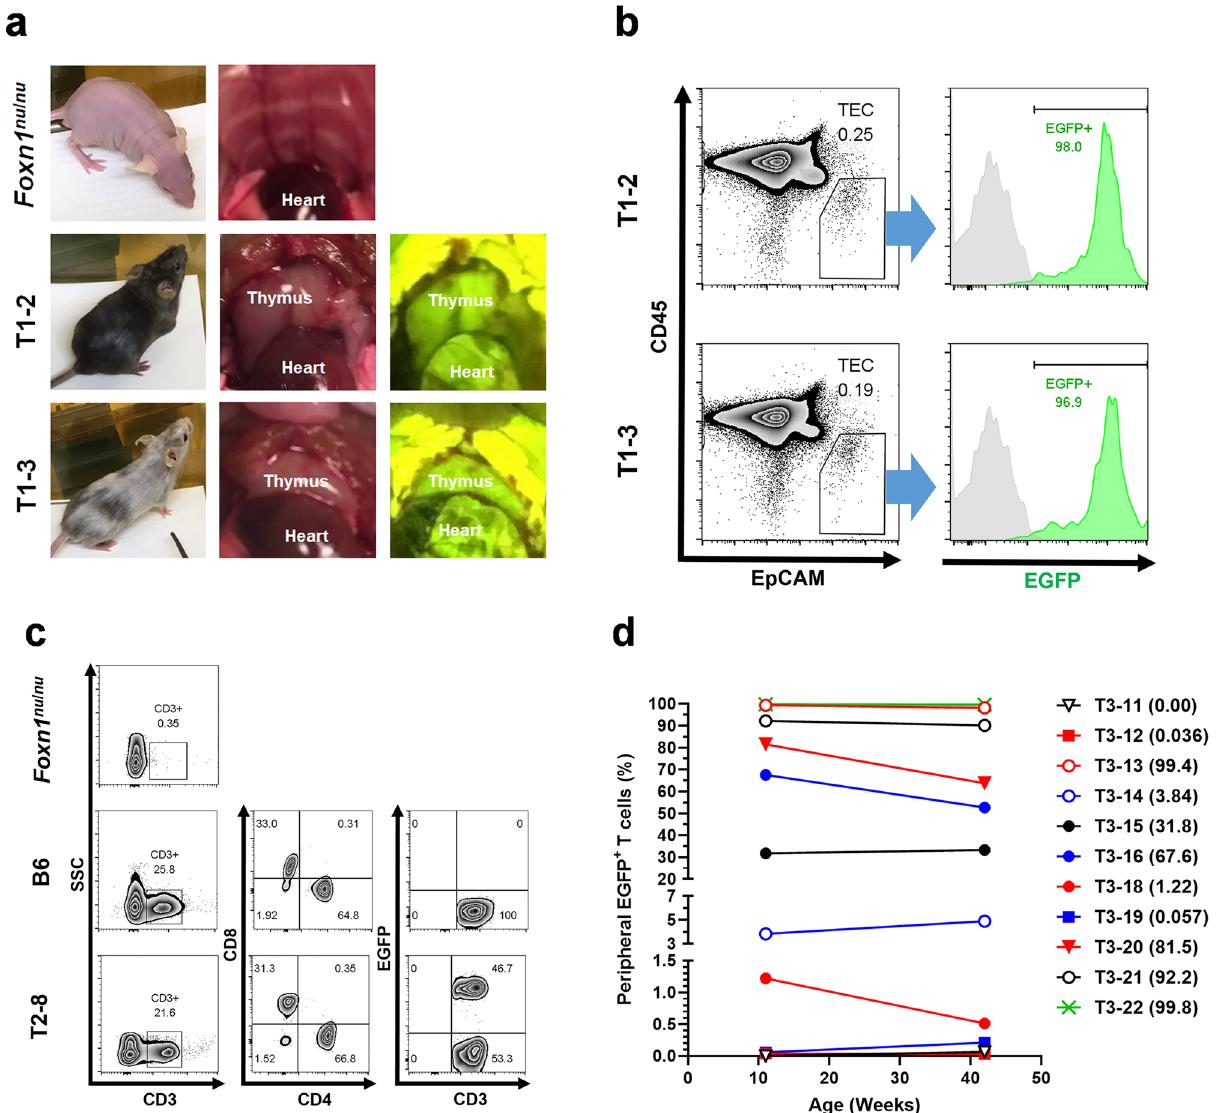
Figure 1. General characterization of thymus-complemented chimeric mice that were generated by blastocyst complementation—that is, injection of C57BL/6 (B6) embryonic stem cells expressing CAG-EGFP (ES CAG-EGFP ) into nude KSN/Slc ( Foxn1 nu / nu ) blastocysts. ( a ) Appearances and thymi of a nude ( Foxn1 nu / nu ) mouse and two B6 ESC CAG-EGFP → Foxn1 nu / nu chimeric mice (mice nos. T1-2 and T1-3). The nude mouse was athymic and both chimeras had EGFP-positive thymi. ( b ) Flow cytometry analysis of thymic cells derived from the two chimeric mice. Thymic cells were sorted against CD45 and EpCAM intensity, and the fractions of thymic epithelial cells (TECs; CD45 − EpCAM + ) were extracted (percentages of TECs were 0.25% and 0.19%, respectively), and then sorted against EGFP fluorescence. Almost all TECs of the chimeras were EGFP positive (98.0% and 96.9% in nos. T1-2 and T1-3, respectively). B6 control, gray; chimeras, green. ( c ) Generation of peripheral T cells in B6 ESC CAG-EGFP → Foxn1 nu / nu chimeras. Representative flow cytometry analysis of peripheral T cells of Foxn1 nu / nu , B6, and chimeric (mouse no. T2-8) mice, demonstrated as zebra plots. CD3 + cells are marked in boxes, with their percentages in the left column. CD8 + or CD4 + cells and EGFP + CD3 + or EGFP − CD3 + cells, respectively, of the B6 mouse and the chimera are indicated in the middle and right columns. Percentage of cells in each of four divided sections is shown. In the case of chimera no. T2-8, about 50% of the T cells were EGFP + . ( d ) Changes in percentages of peripheral EGFP + T cells of 11 chimeras between 11 and 42 weeks of age with varying chimerism. The identification numbers of the individual chimeric mice are indicated at right, with percentages of EGFP + peripheral T cells at 11 weeks of age in parentheses. There were no significant differences in chimerism between the ages ( P = 0.1541 by paired two-tailed Student’s t